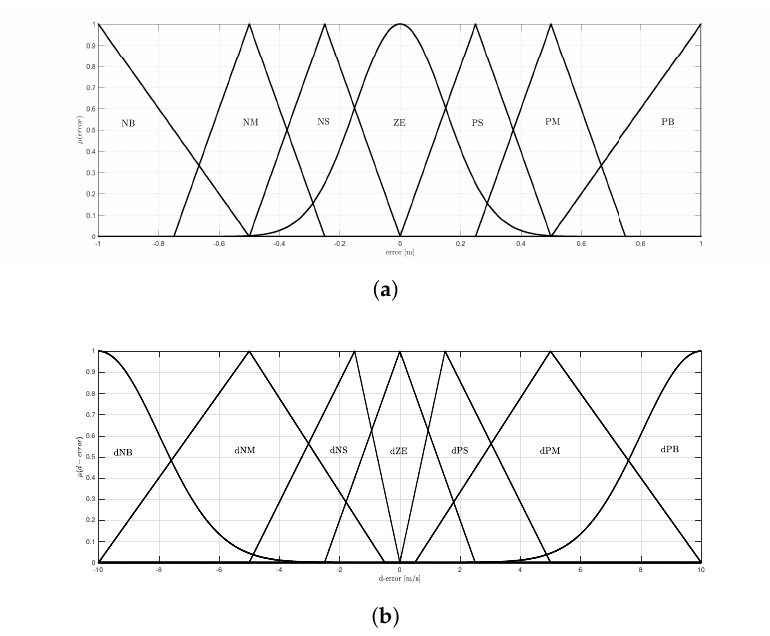
Figure 4. Linguistic variables ( a ) error and ( b ) derived of the error.